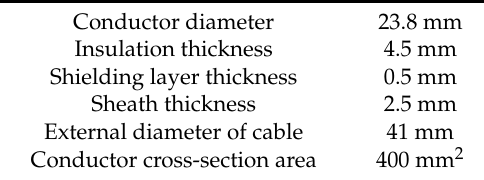
Table 1. Parameters of cable joint.